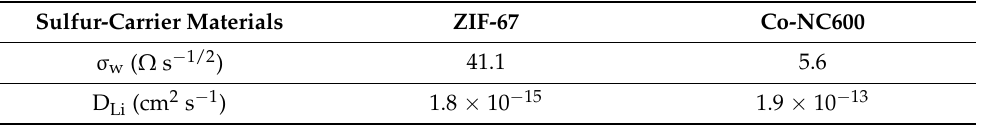
Table 2. The value of the lithium ion diffusion coefficient and Warburg coefficient in the two types of batteries.